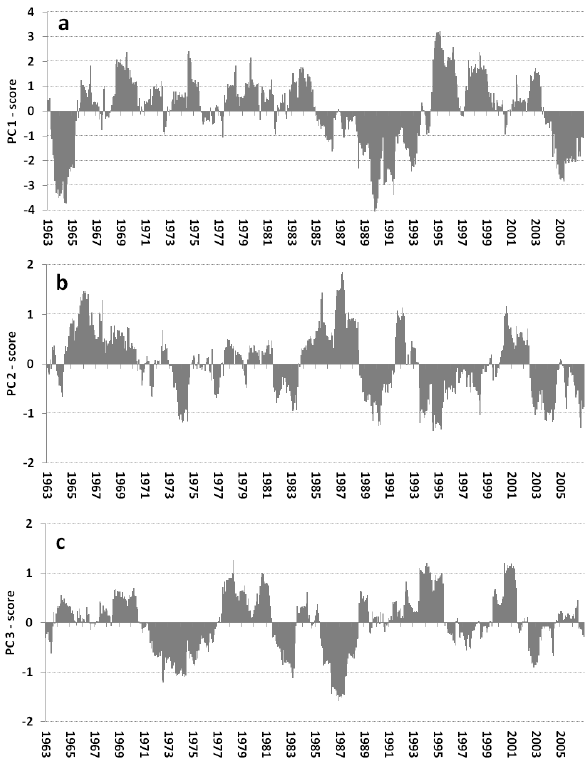
Fig. 7. PC scores of the SPI-24 in the Xijiang River basin.